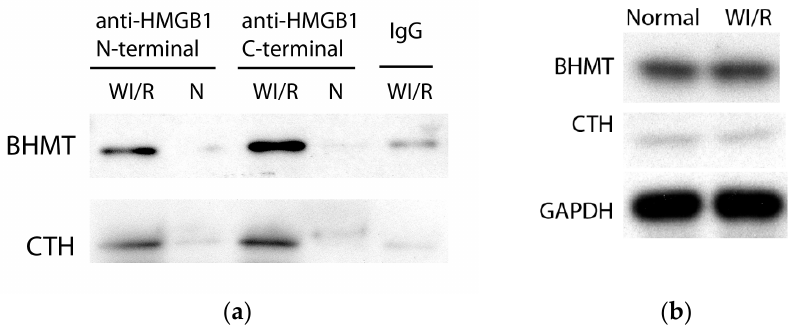
Figure 3. ( a ) Verification of identified proteins using Western blotting. The levels of target proteins were higher in co-IP eluates from WI/R cytoplasmic extract reacted with two different anti-HMGB1 antibodies. Extracts containing the same protein amount were subjected to reactions with different antibodies in co-IP experiments; the same volumes of eluates were subjected to WB in each lane within each candidate protein group. N, normal; WI/R, warm ischemia reperfusion; ( b ) Relative amount of the binding proteins in cytoplasm from WI/R versus normal livers. The relative amount of betaine–homocysteine S -methyltransferase 1 (BHMT) and cystathionine γ -lyase (CTH) in cytoplasm was not increased in WI/R animals.